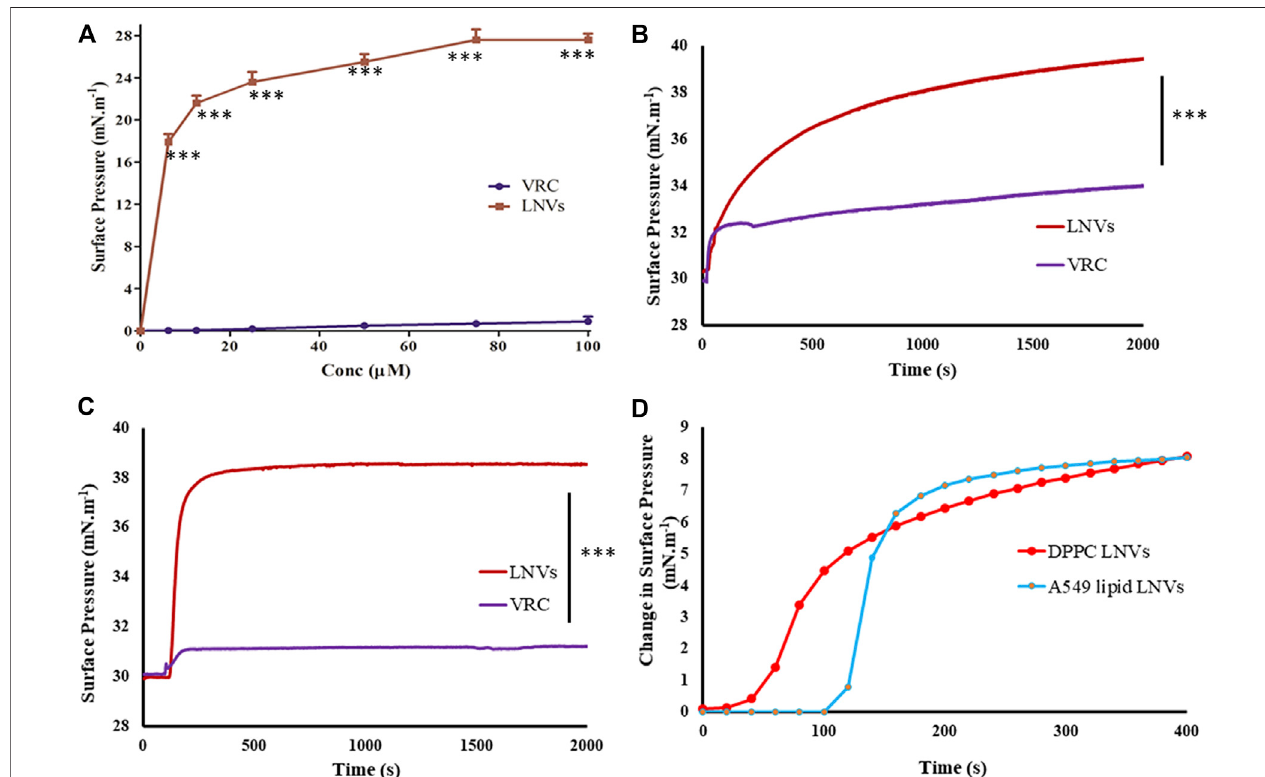
FIGURE 5 | (A) Surface activity pro fi le of voriconazole (VRC, purple) and its lipid nanovesicles (LNVs, red) at air/water subphase employing Langmuir Blodgett trough fi lledwithPBSpH7.4(10 mM)andadjustedto15 cm 2 area;lipidmonolayerinteractionstatisticsofVRCandLNVsat (B) DPPCandat (C) A549cellslipidextract (0.5 mM) at 30 mN m − 1 of pressure; (D) Initial change in the surface pressure observed with LNVs intercalation into DPPC and A549 cell lipid monolayers for time- duration of 400 s. Data represent mean ± SD values ( n (cid:2) 3). Data sets were compared with pure voriconazole (*** p < 0.0001).